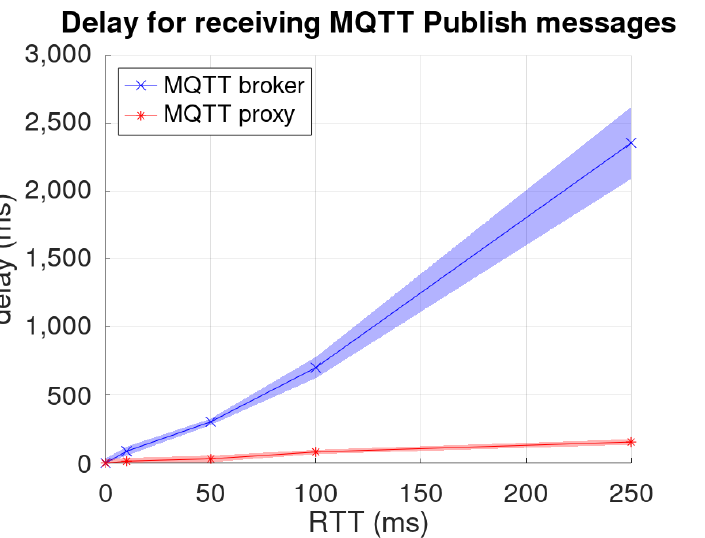
Figure 12. Delay between sending MQTT Publish messages (publisher) and their reception